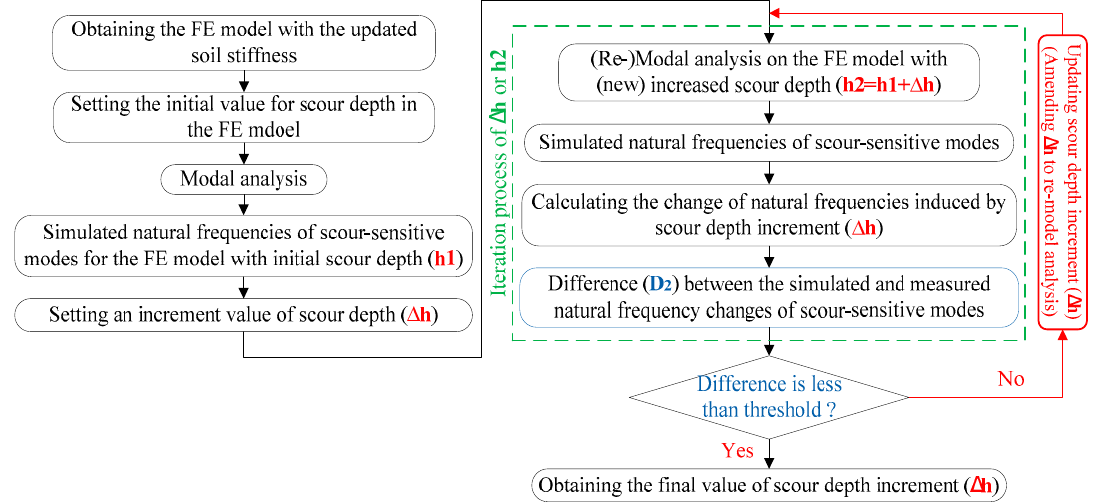
Figure 16. Algorithm for identifying scour depth.